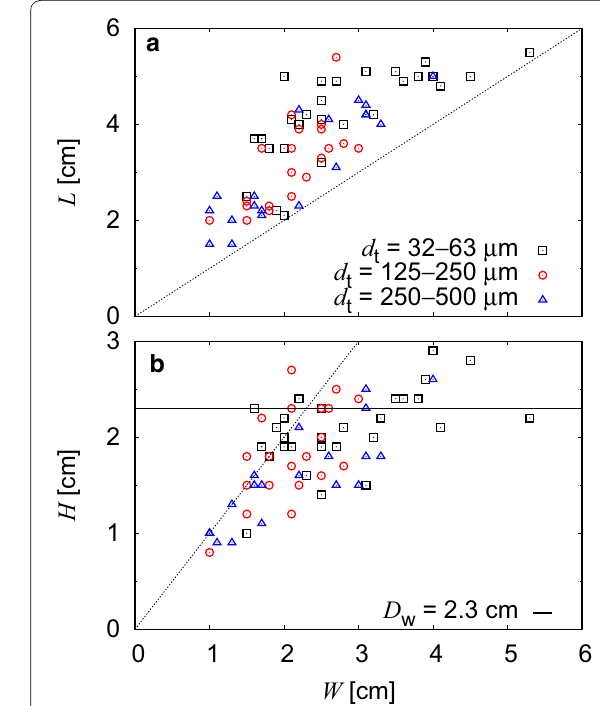
Fig. 9 Size of aggregates. Length, L , width, W , and height, H of aggregates measured in EXP3–5 ( C s = 10% and t = 5min ): a L vs. W and b H vs. W . Black squares, red circles, and blue triangles indicate results in EXP3, EXP4, and EXP5, respectively. Dashed lines indicate L = W = H ; L ≥ W is satisfied for horizontal size. The solid line in b indicates the maximum water depth of the mixture in the pot under static conditions: D w =